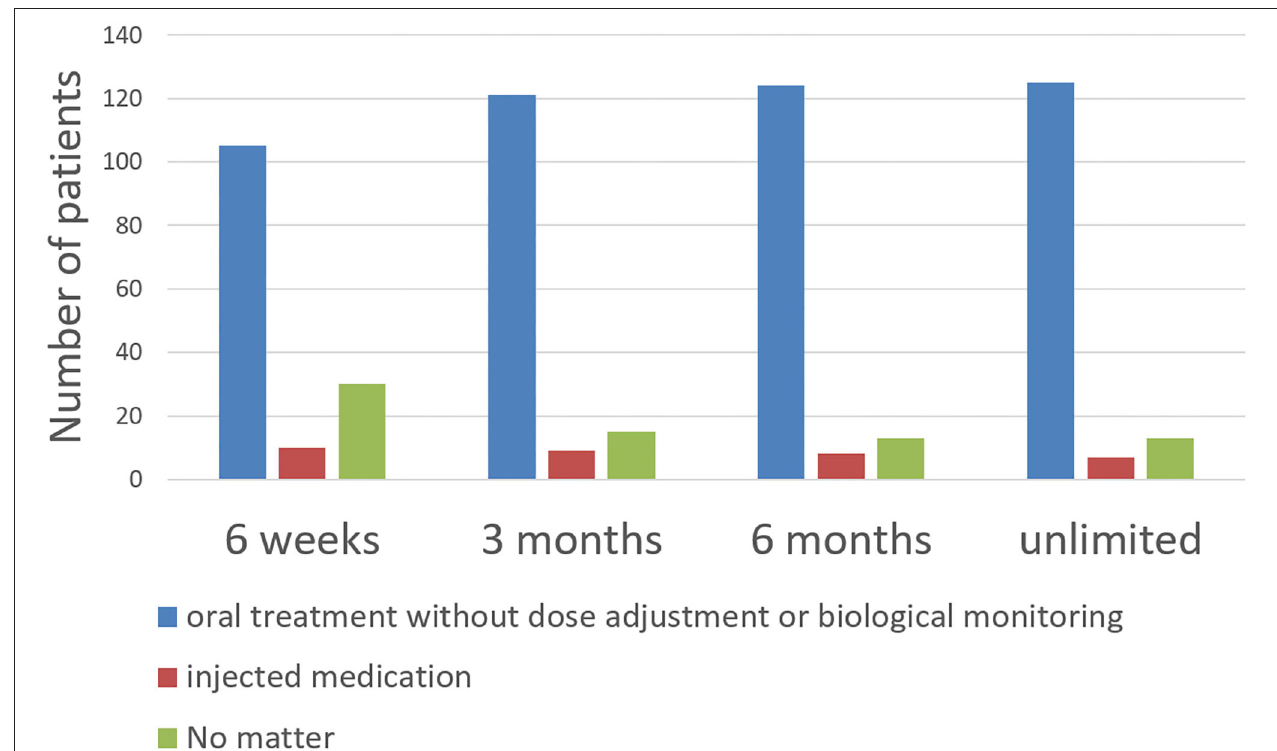
FIGURE 1 | Patient preferences in terms of administration modality according to expected duration of